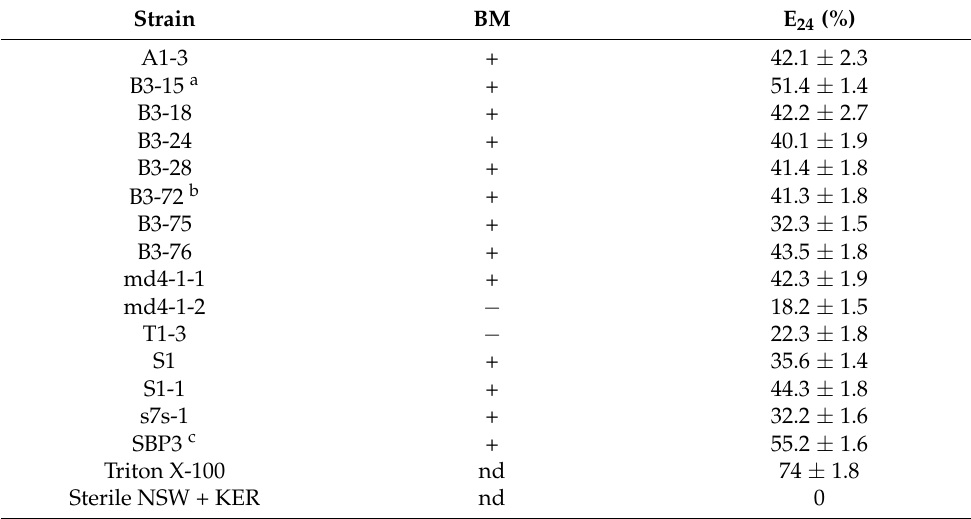
Table 3. Screening of biosurfactants/bioemulsifiers production of 15 selected hydrocarbon-utilizing bacilli on methylene blue agar plates (BM) and emulsifying index (E 24 ) of their cell-free supernatants in NSW + KER (1:1 v / v ), in comparison with the industrially synthesized surfactant Triton X-100. Sterile NSW + KER was used as negative control. (+) presence of halo in BM. Data are expressed as averages and standard deviations (n =